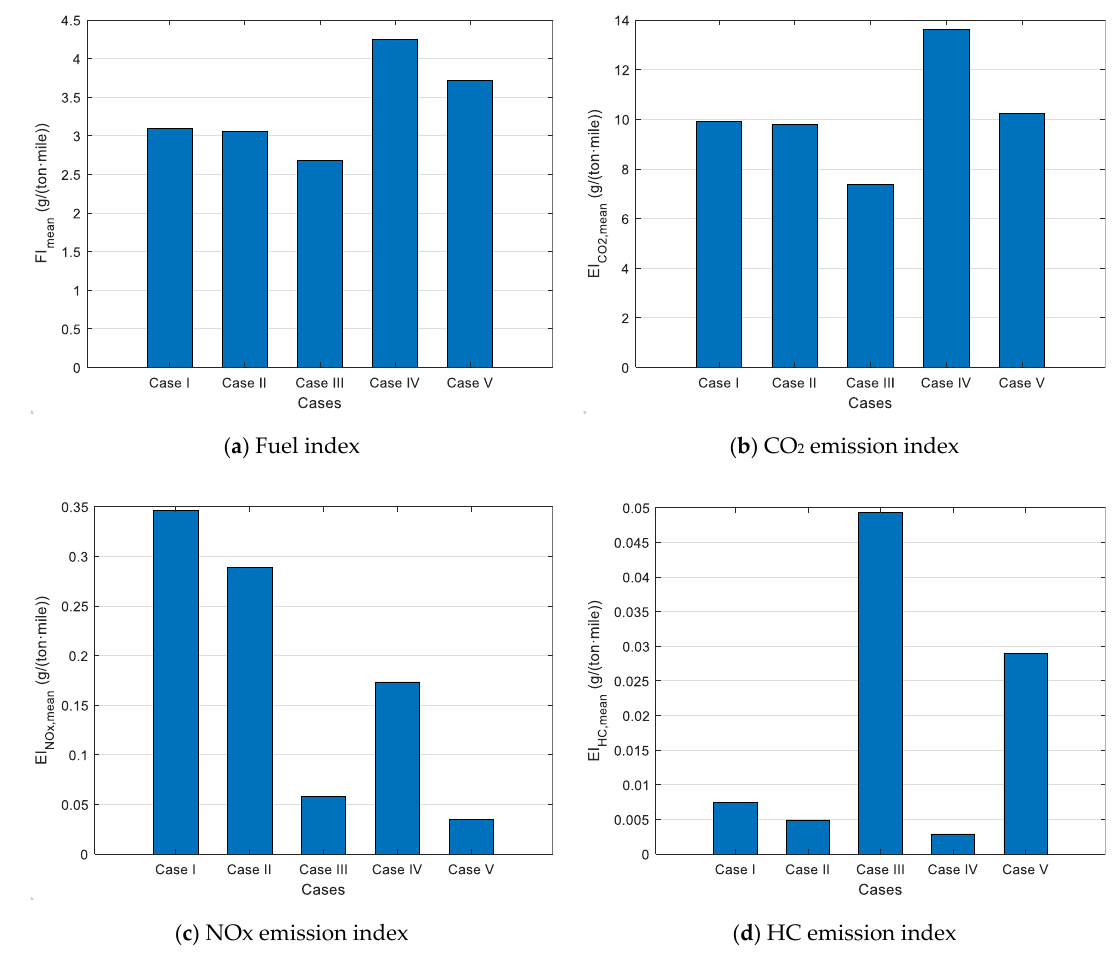
Figure 6. Fuel and emissions indices in different cases.